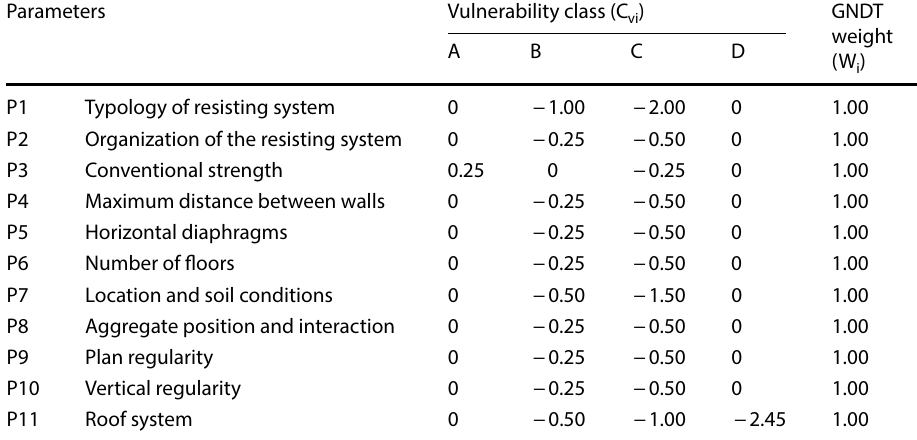
Table 2 GNDT Method Classes and Weights for RC Buildings